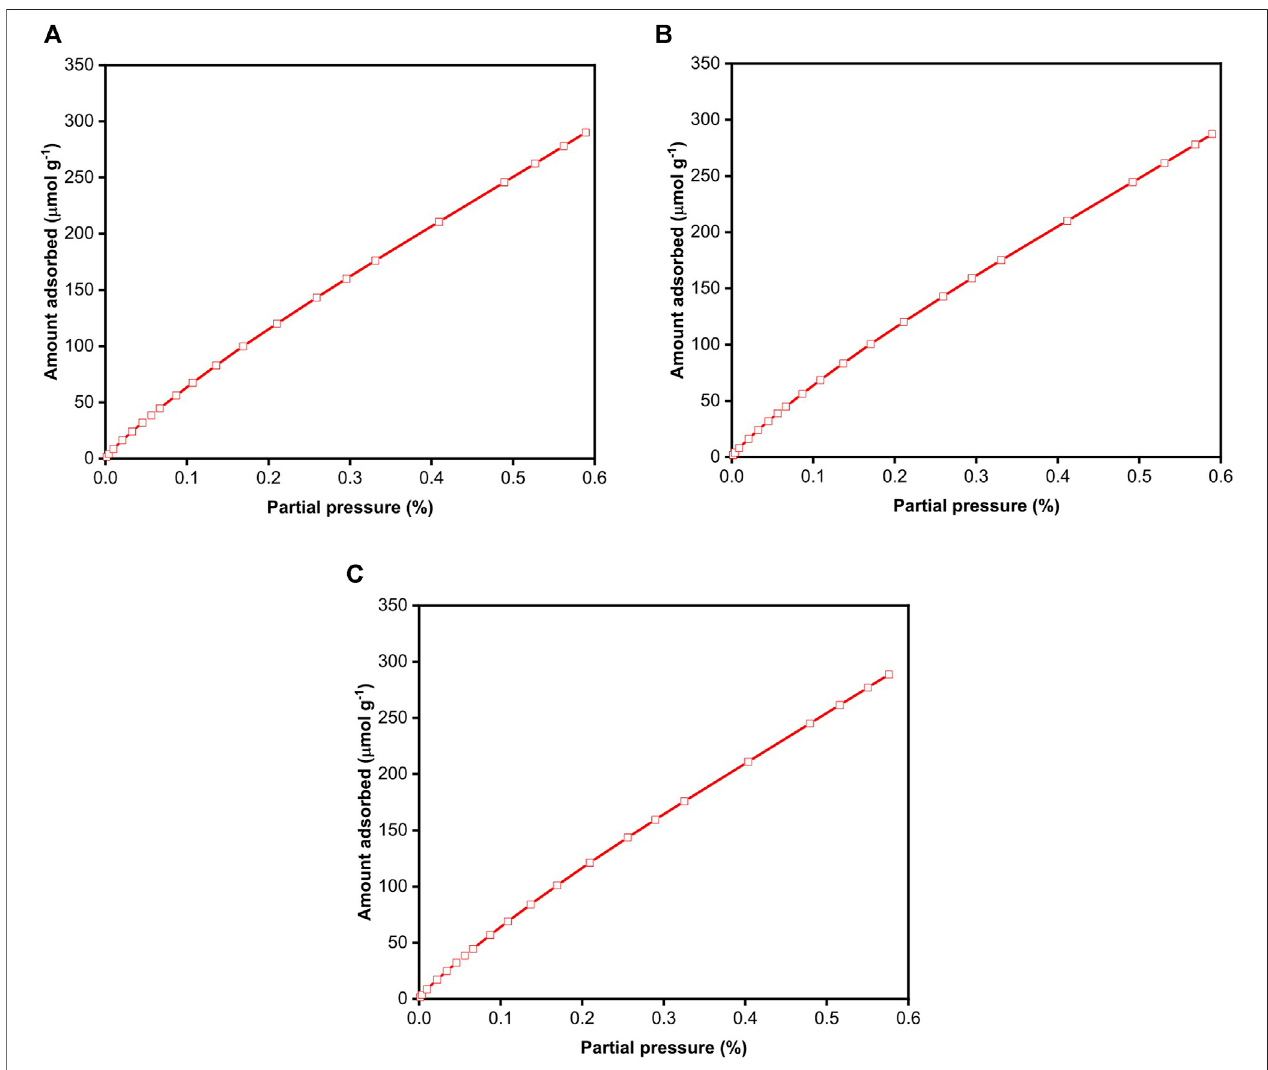
FIGURE 5 | n-Octane adsorption isotherms on freeze-dried BC measured using iGC. (A) First adsorption-desorption run immediately after pre-conditioning, (B) second adsorption-desorption immediately after the fi rst run and (C) third adsorption-desorption run immediately after the second run.